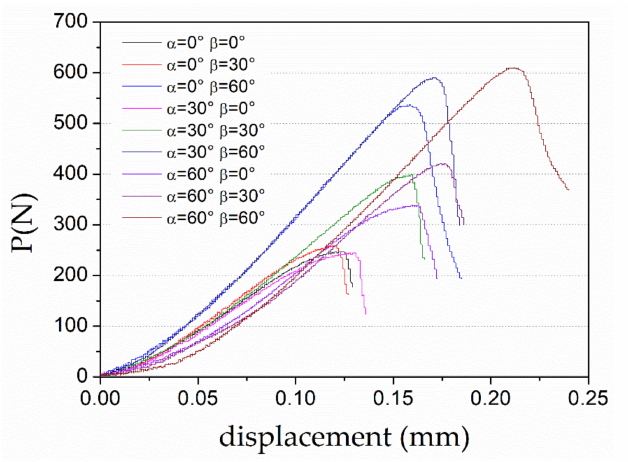
Figure 11. Curve of displacement and load with respect to horizontal vertical deflection angles.